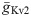
Burst susceptibility of models under SK block.(A) CV ISI during normal spontaneous firing (Ctrl) and with SK conductance reduced to 0 (SK Block). Left plot with orange points is approximated from Figure 2A of [32]. Right plot with blue points shows the population of models. Black, orange and green circles indicate CV ISI values of traces shown in (B). (B) Example voltage traces for spontaneous firing (top) and STO (bottom) in the normal (Ctrl) and SK Block conditions, for parameter sets demonstrating 3 behaviors: large increase (green), small increase (orange) and no change (black) to CV ISI under SK Block. (C) Kv2 conductance (x-axis) vs. spontaneous firing CV ISI (y-axis). Inset shows zoom in on red boxed region (low g¯Kv2). (D) PLSR coefficients for CV ISI for all parameter sets with g¯Kv2<0.005. (E-G) Scatter plots of 22 models in which all burst characteristics could be calculated, showing highest correlated parameter (x-axes) with each burst characteristic (y-axes). Each point is a parameter set.